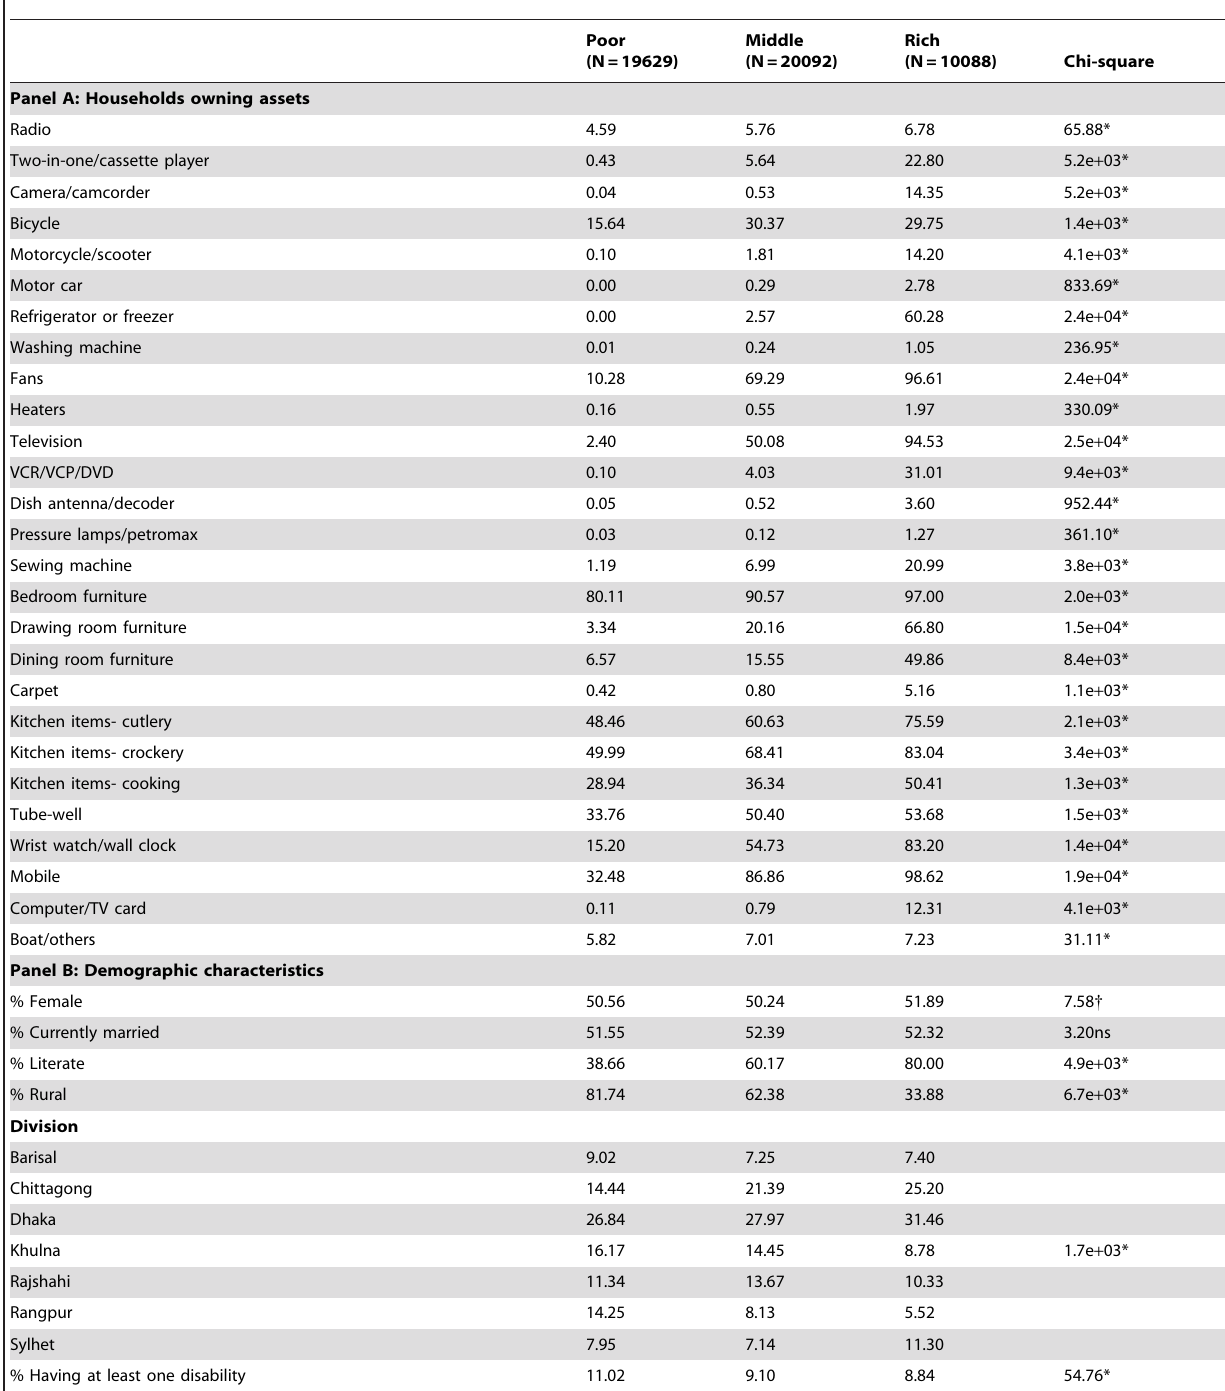
Table 2. Percentage of households owning specific assets, and selected demographic characteristics by categories of wealth index.